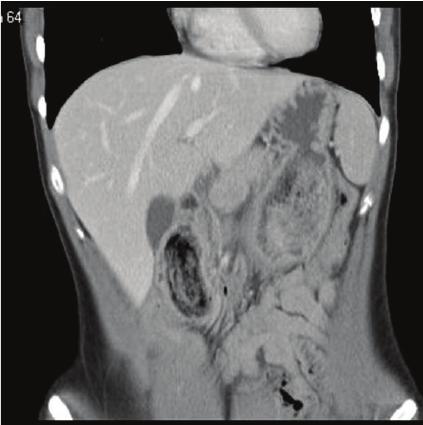
Figure 1: CT image showing bezoar extension from stomach into duodenum.